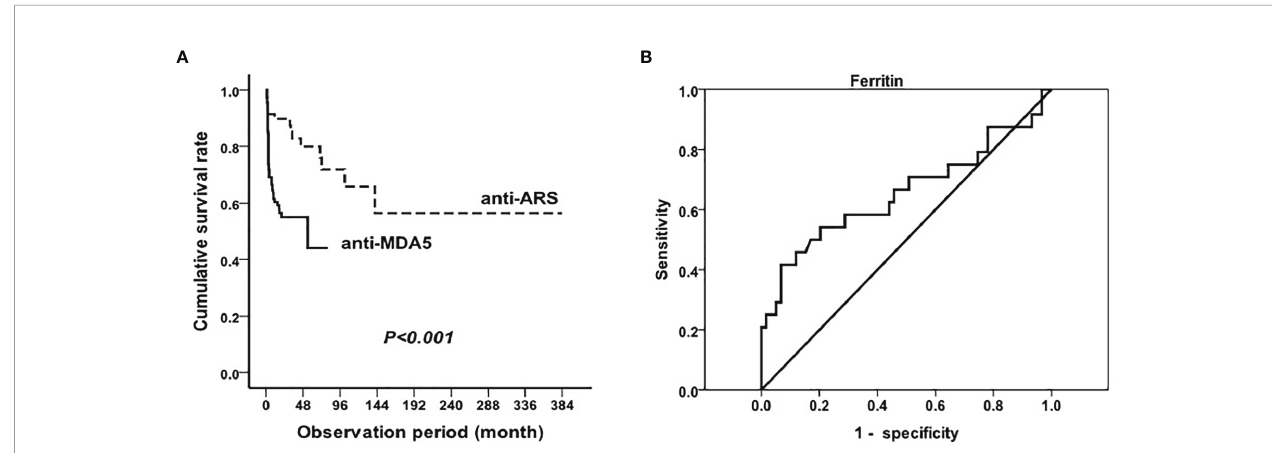
FIGURE 3 | Mortality in RP-ILD in anti-MDA5 and anti-ARS positive DM and prognostic value of serum ferritin Survival analysis in RP-ILD patients with anti-MDA5 or anti-ARS antibodies (A) and prognostic value of serum ferritin in MDA5 + DM (B) .